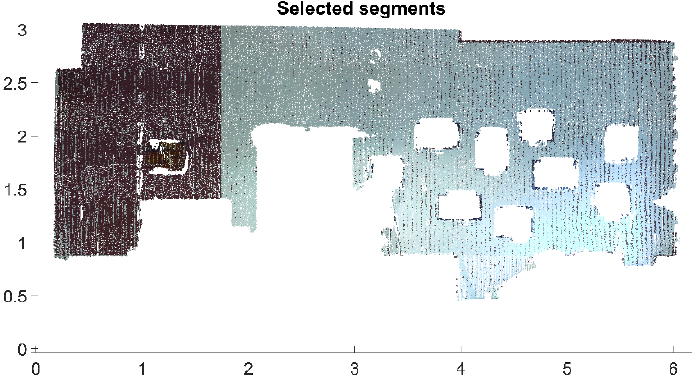
Figure 11. Segmented point cloud—additional curve segmentation used.